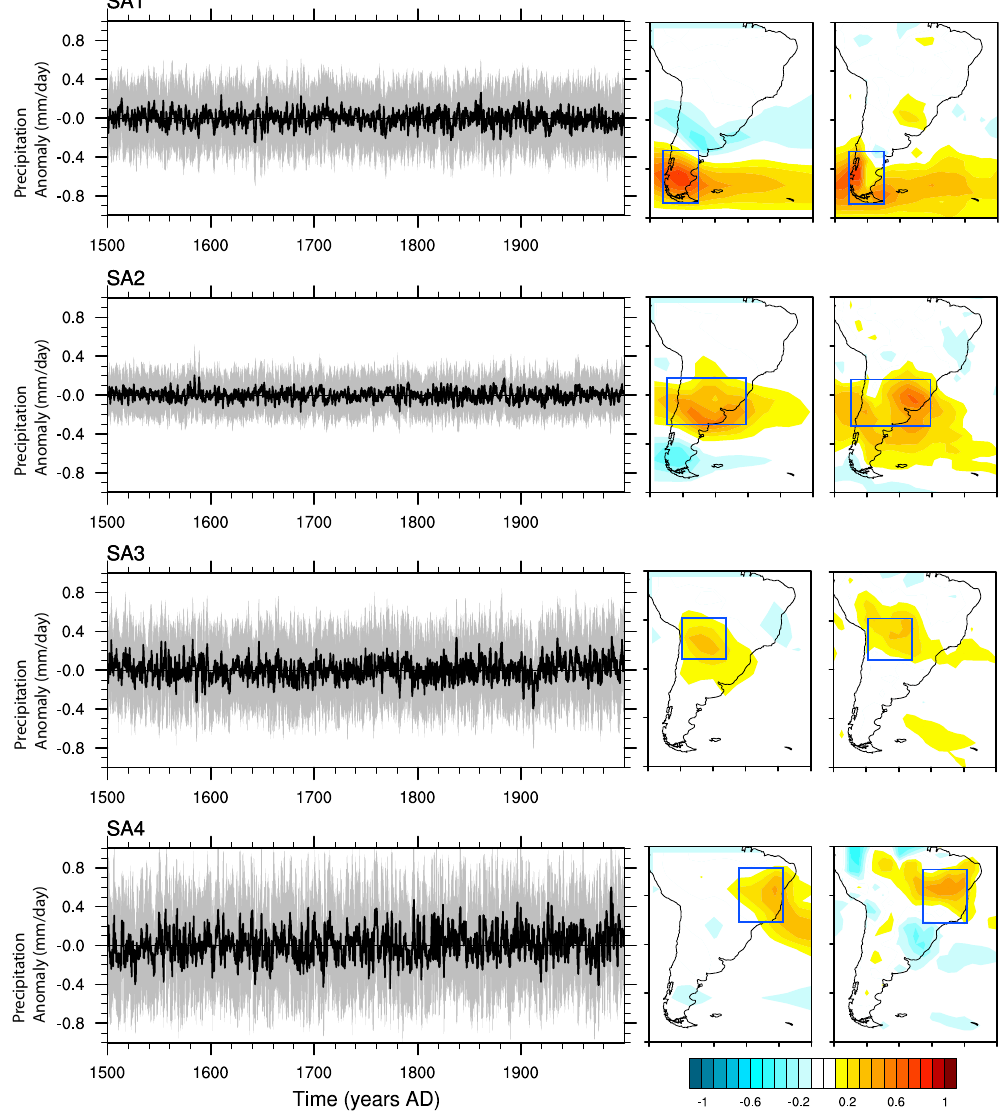
Fig. 6. Time series of the regional monthly precipitation anomalies against the pre-industrial mean smoothed with a 12-month running mean for illustrative regions in South America. The ensemble mean is shown in black and the one standard deviation range in grey. The correlation pattern of the respective regional precipitation index with the spatial precipitation pattern together with the selected region (blue box) is shown for both CTRL1990 (left maps) and ERA-40 (right maps).